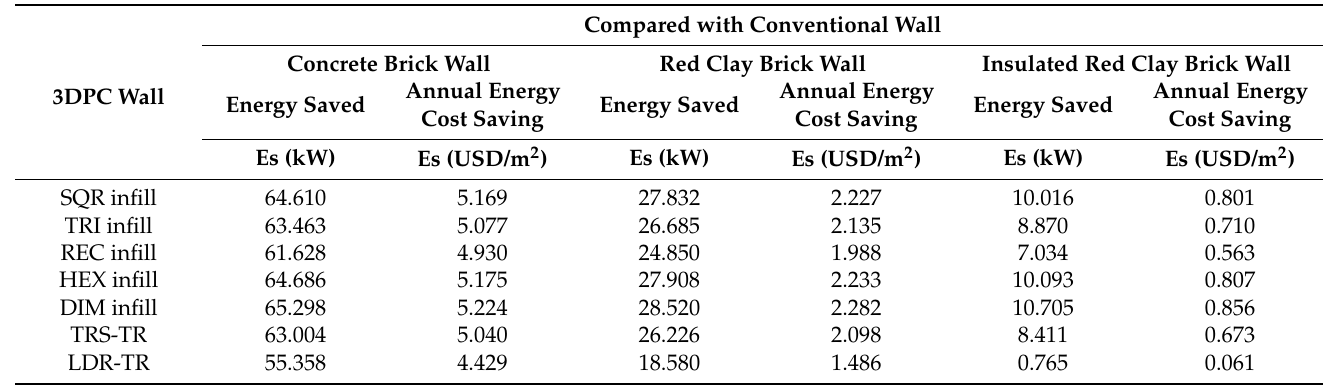
Table 5. Energy-saving for each 3DPC wall compared with three different types of conventional